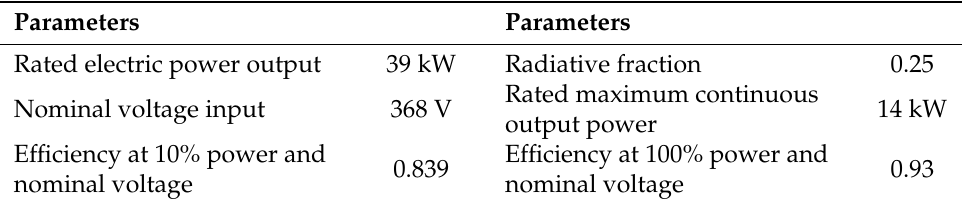
Table 3. Parameters of reference PV models.